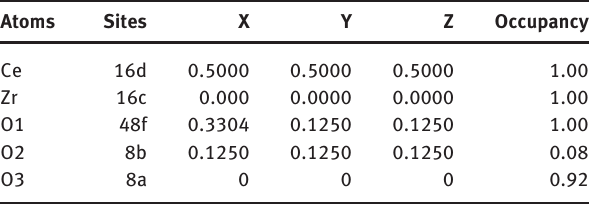
Table 7: Occupancy state with the atomic coordinates for various atoms.